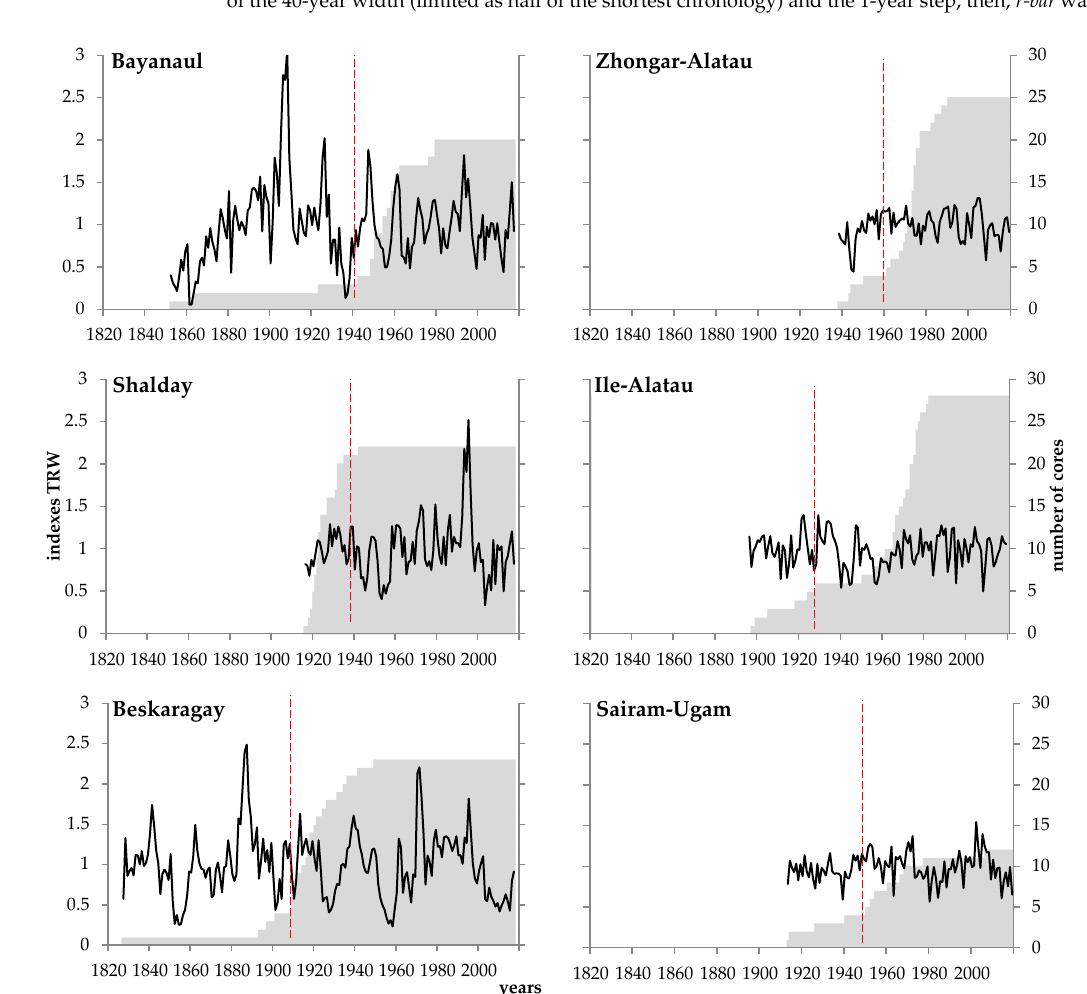
Figure 3. Conifer growth dynamics. Line represents standard local chronology; shaded area represents sample depth (number of cores for each year); and vertical dashed line shows the first year of EPS ≥ 0.85, i.e., beginning of period suitable for dendroclimatic